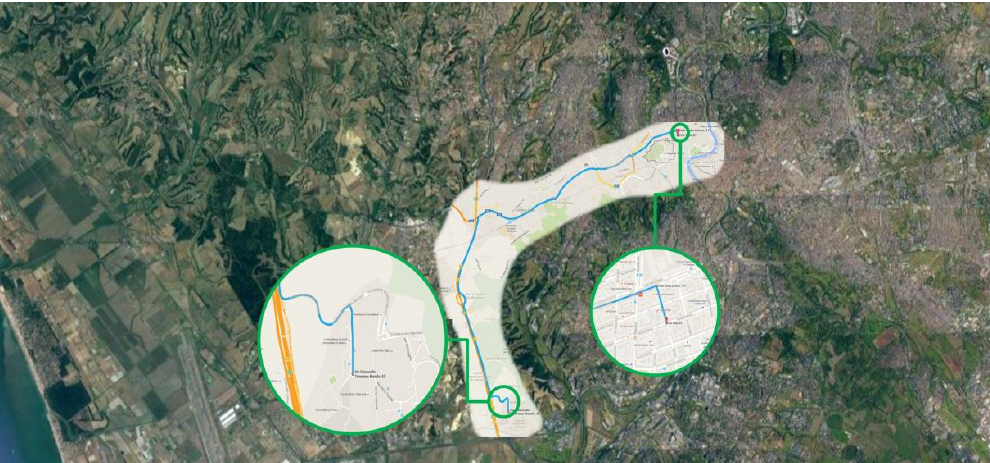
Figure 2. Urban with high traffic density section.